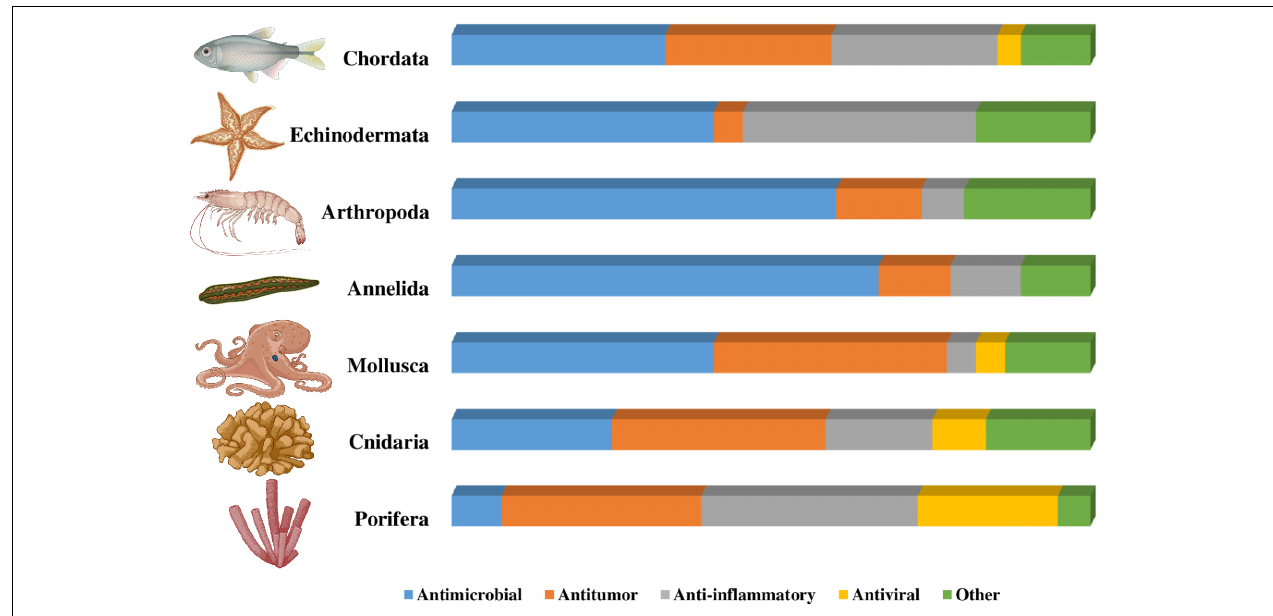
FIGURE 1 | Distribution of peptides according to phylum and function. The figure shows the distribution of the peptides mentioned in this review according to the phyla described and the functionality of the peptides isolated from marine organisms. The bar marked "Other" includes peptides with analgesic, anti-fouling, photo-protective, insecticidal, anti-diabetic, immunomodulatory, anti-obesity, and protiotic activity, and human food